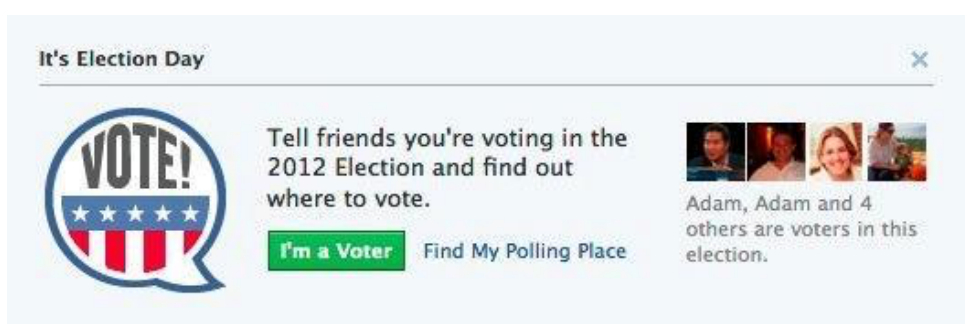
Figure 1: 2012, United States (“Election Day 2012 on Facebook | Facebook Newsroom”,